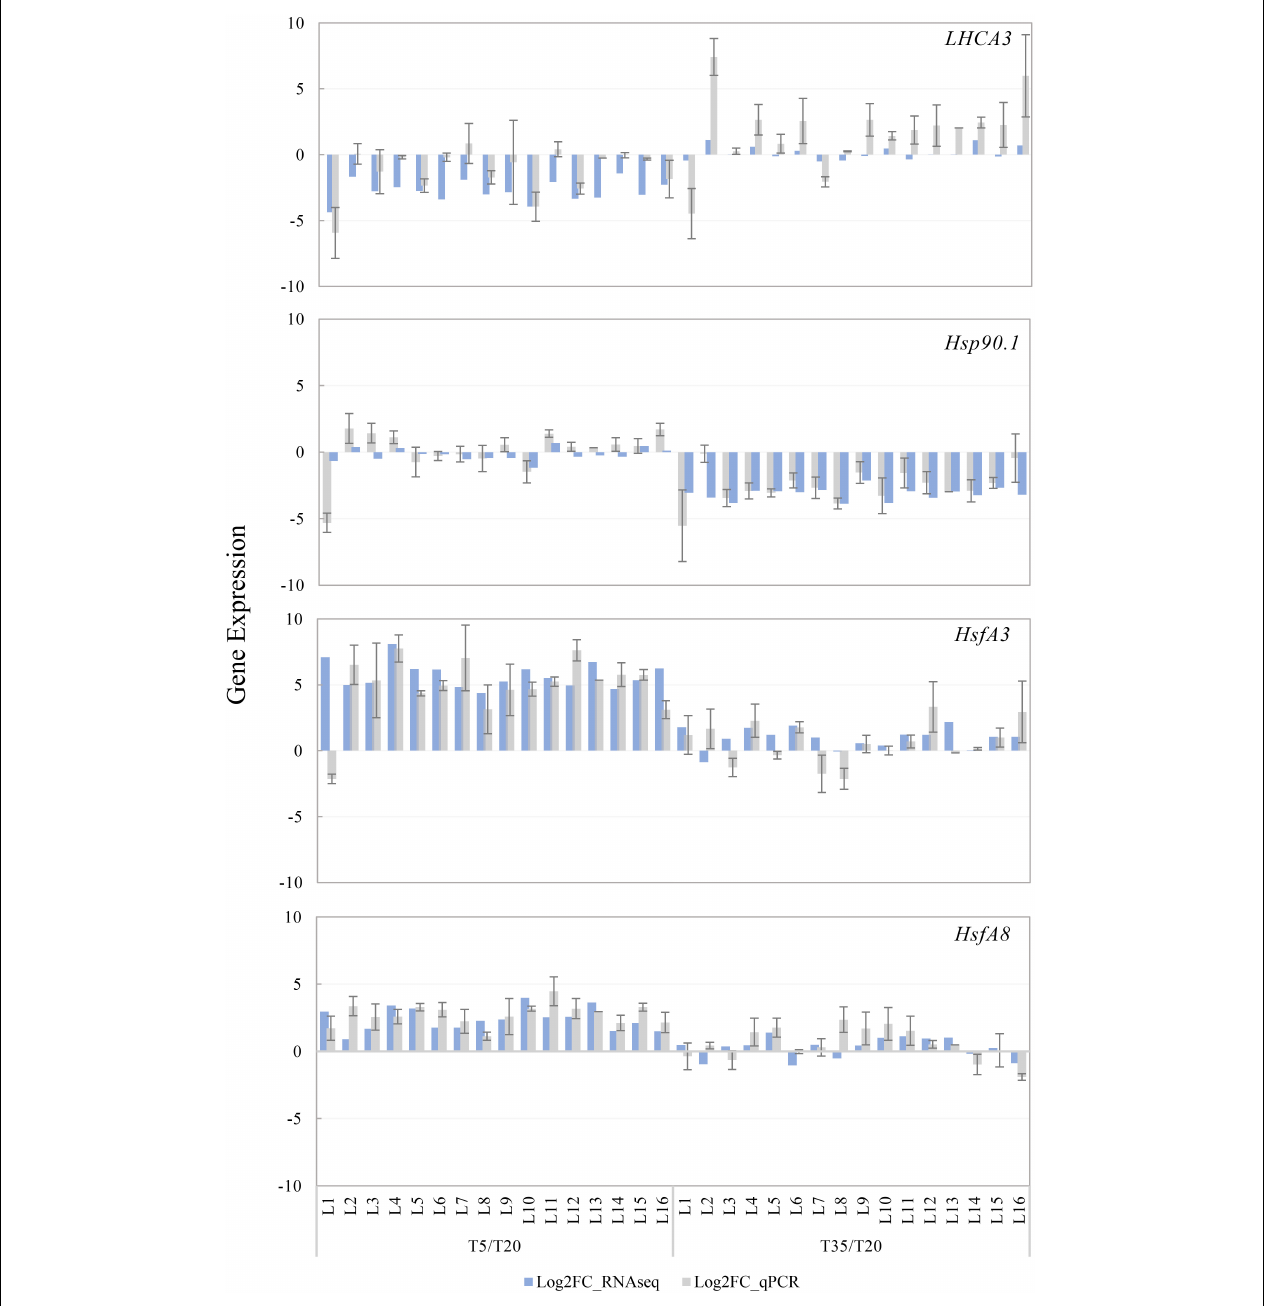
FIGURE 8 | Expression validation of four DEGs through quantitative real-time (qRT)-PCR and RNA-seq analysis. The T20 treatment is the reference and the relative expression was determined by log2 FPKM and Log2 (fold change) compared to the reference. All qRT-PCR reactions were performed from triplicate biological samples. Mean of three replicates ± SE is